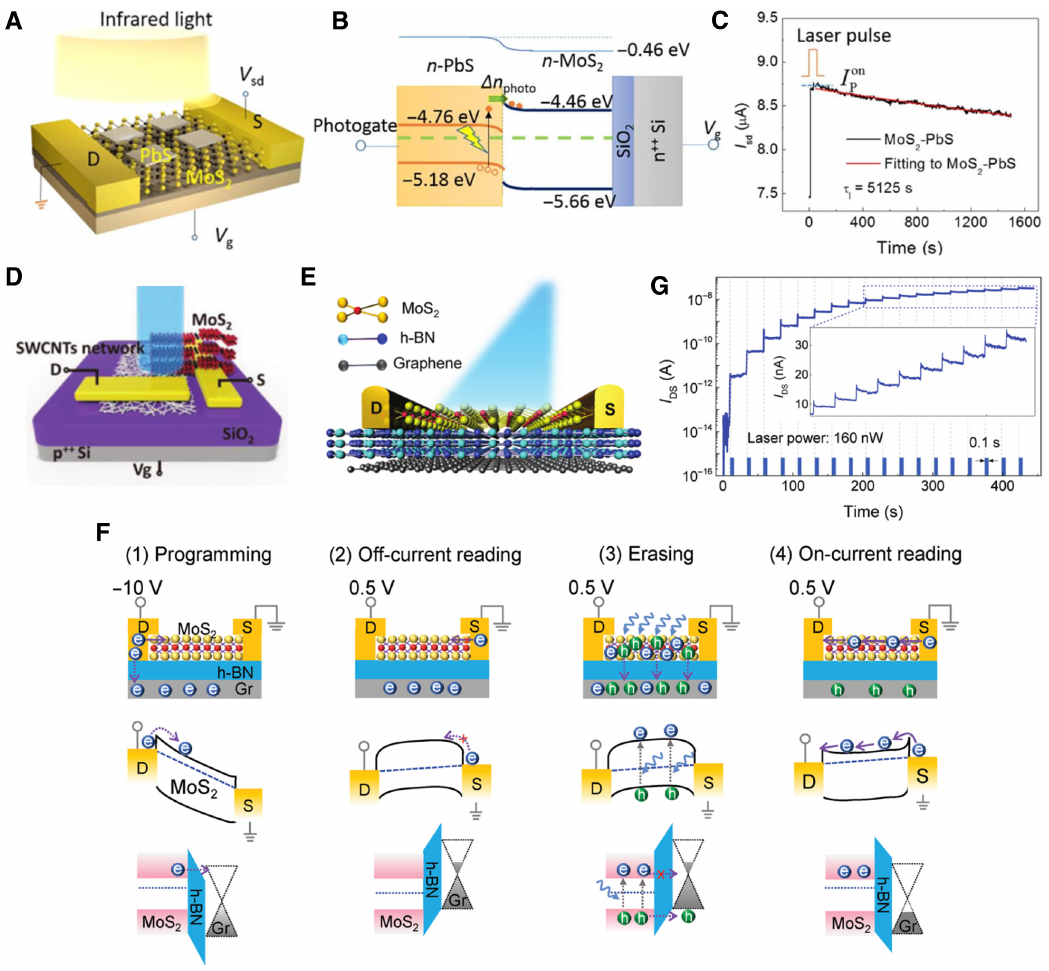
Figure 4: Photonic memristor based on vdWs heterostructure. (A) Schematic of MoS -PbS heterostructure extending absorption range to infrared. (B) Band alignment of heterostructure showing 2 photogate effect on the PbS side. (C) Time evolution of I in MoS -PbS heterostructure after light pulse illumination. (A–C) Reproduced ds 2 with permission [38]. Copyright 2018, American Association for the Advancement of Science. (D) The schematic and the SEM image of the MoS /SWCNTs network heterostructure on 300 nm SiO /Si substrate. (D) Reproduced with permission [41]. Copyright 2019, Wiley-VCH. 2 2 (E) Schematic structure of a photonic memristor with the MoS /h-BN/graphene heterostructure. (F) Schematic illustration of the memristor 2 operation (top panels) and corresponding energy band diagram in the lateral (middle) and vertical (bottom) directions of the device for: (1) programming, (2) off-current reading, (3) erasing, and (4) on-current reading. (G) I evolution under consistent light pulses exhibit ds multilevel data storage capability. (E–G) Reproduced with permission [32]. Copyright 2019,